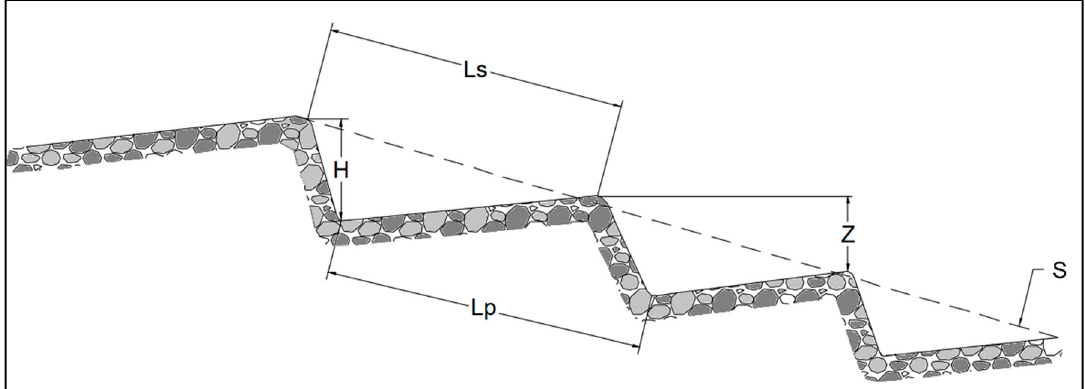
Figure 3. Graphical description of the variables analyzed in the step–pool sequence, i.e., the step–step drop (Z), step–pool height (H), pool–pool spacing (Lp), step–step spacing (Ls), and mean slope (S).